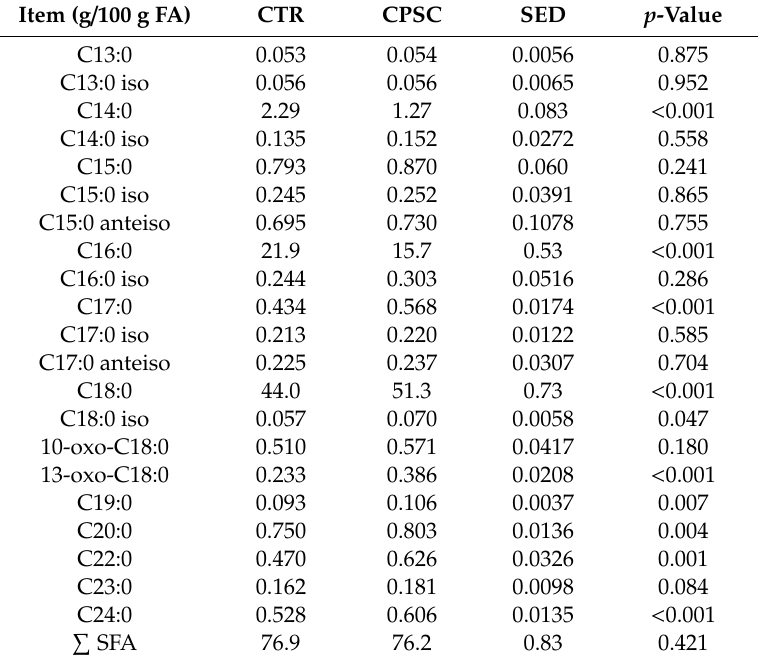
Table 2. E ff ect of feeding cold-pressed sunflower cake on ruminal saturated fatty acid composition in dairy cows (n = 10).